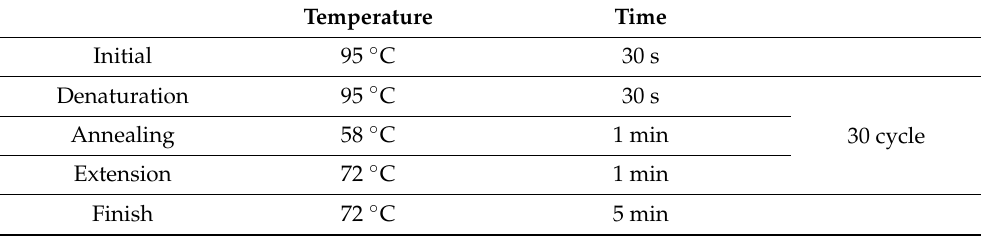
Table 1. PCR program for chicken gender identification.